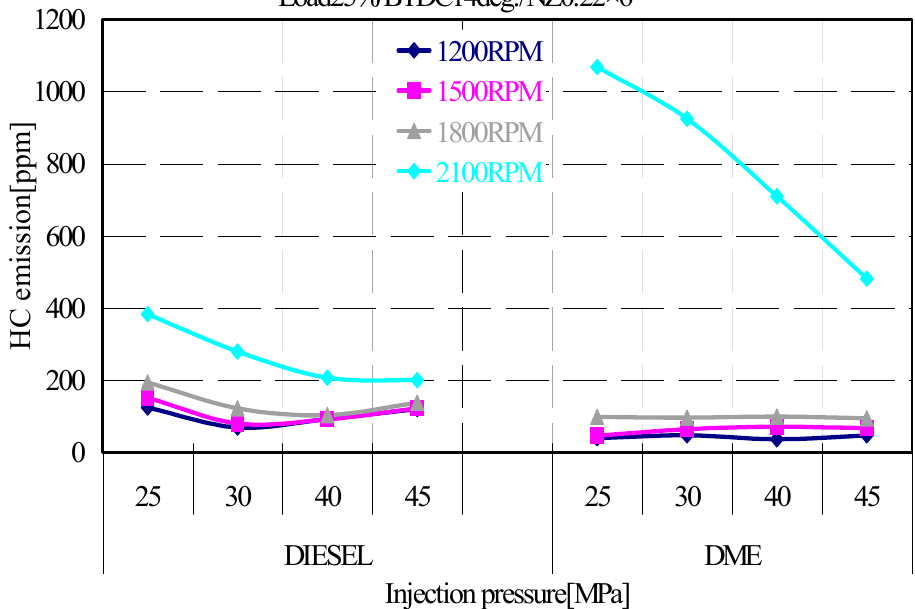
Figure 5. HC emission characteristics of diesel and DME engines without pilot injection as a function of injection pressure and engine speed.